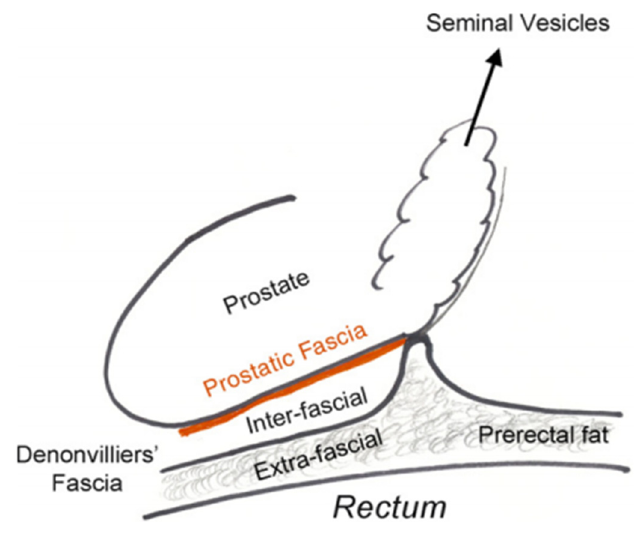
Figure 1. Prostatic fasciae anatomy. Reprinted with permission from [30]. Copyright 2021 Elsevier.